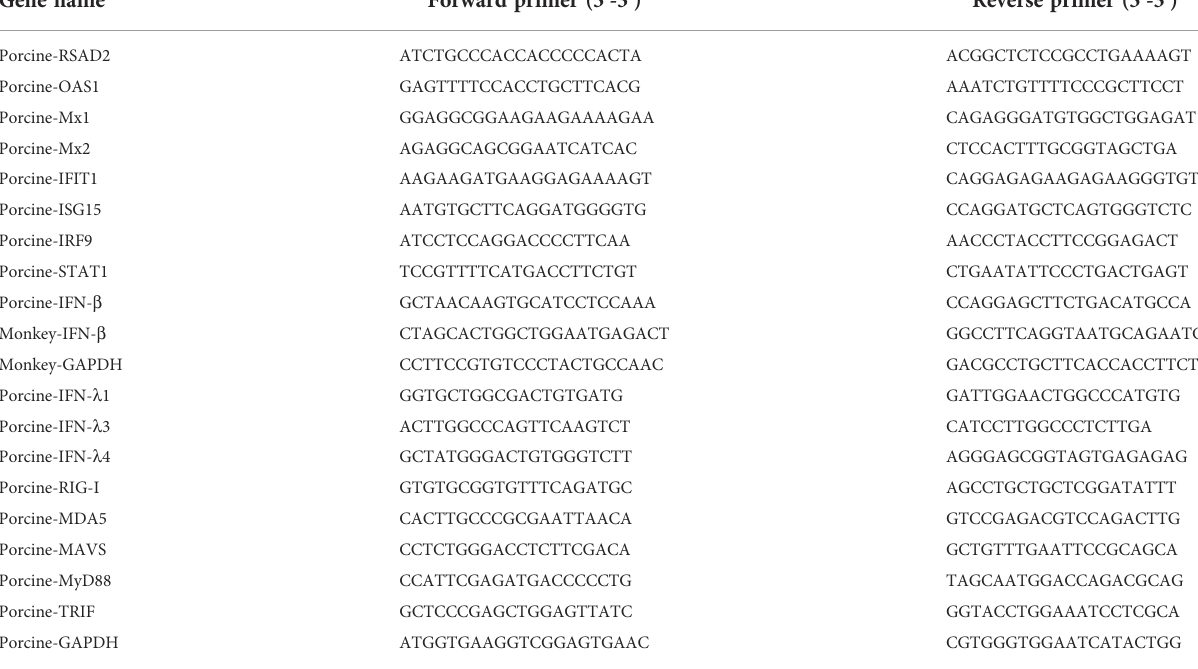
TABLE 1 Primer sequences in this